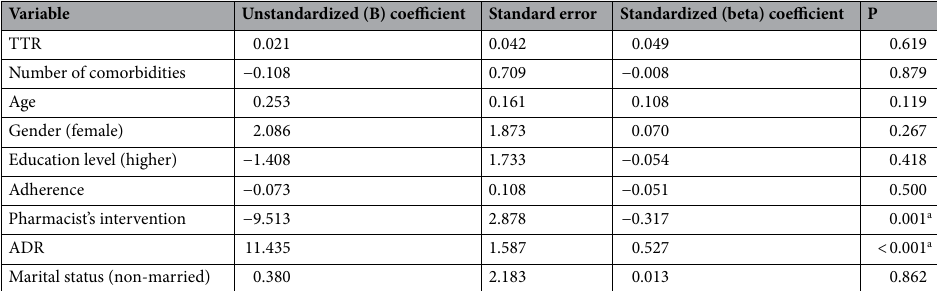
Table 3. Multiple regression for Cro-DASS scores at six months. R 2 = 65.5%; adjusted R 2 = 63.0%, p < 0.001. a Statistically significant.